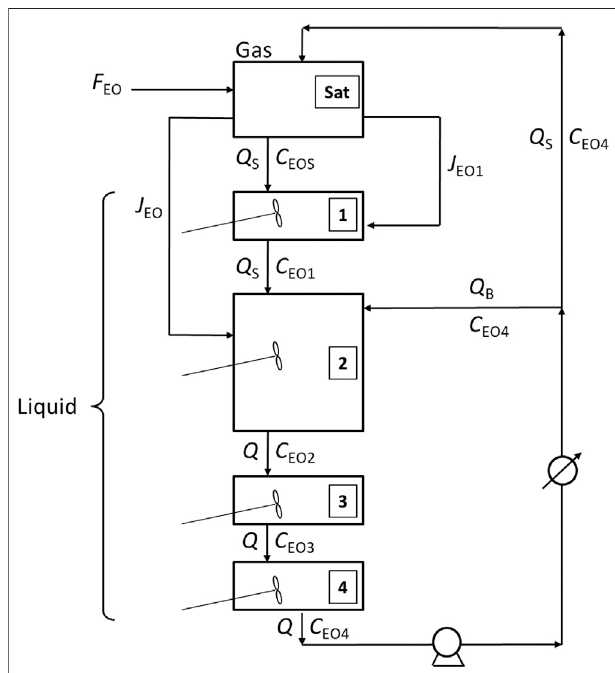
FIGURE 4 | Modeling scheme to describe the Enhanced Loop Reactor